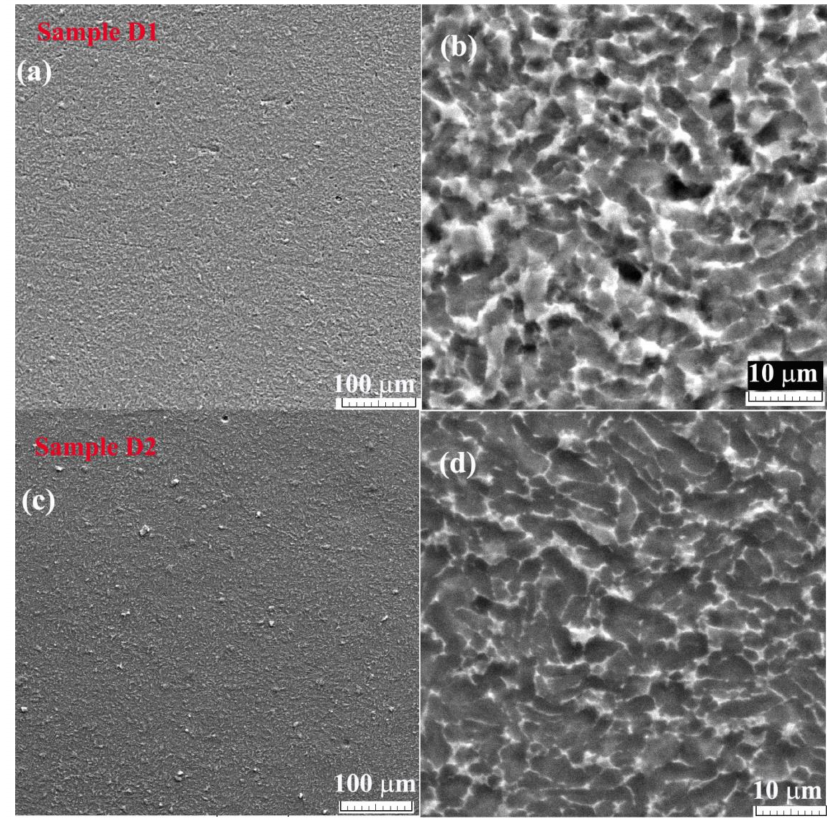
Figure 2. SEM micrographs of the sample surfaces: ( a ) sample D1-500x, ( b ) sample D1-5000x, ( c ) sample D2-500x, and ( d ) sample